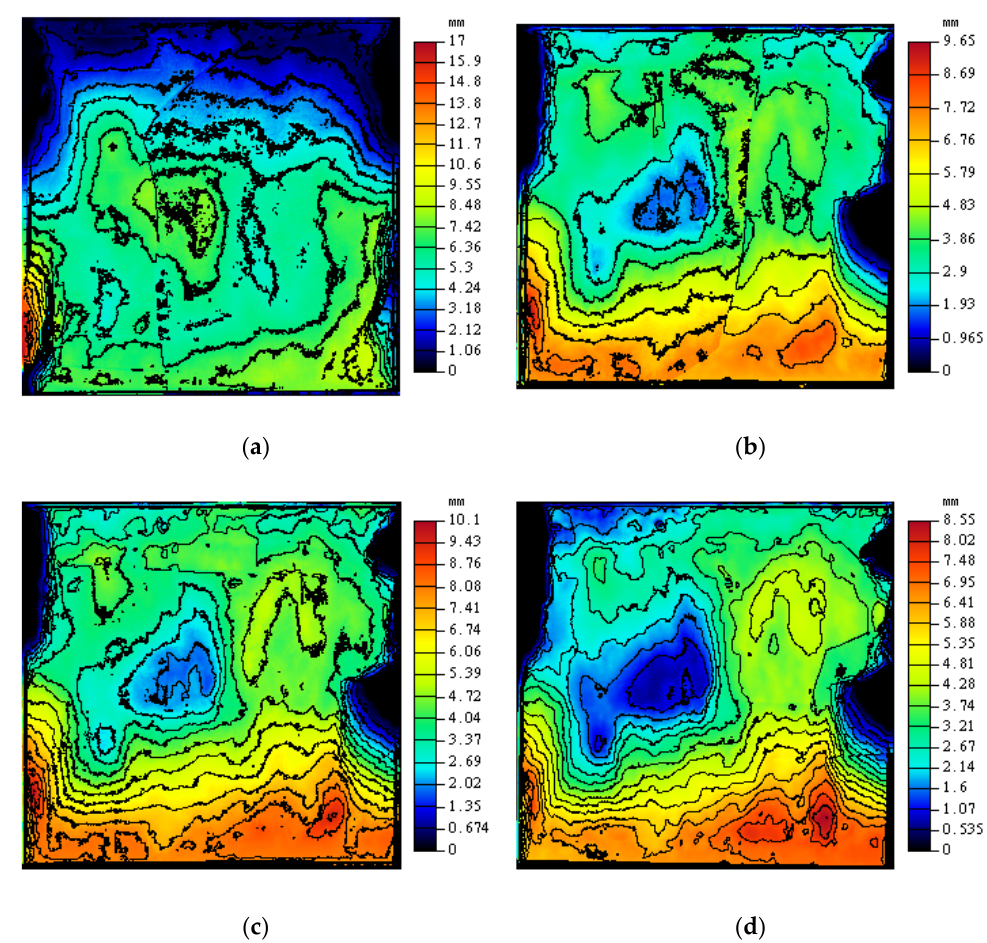
Figure 16. Contour map of CD-3 in cyclic shearing. ( a ) Before test; ( b ) First shearing; ( c ) Second shearing; ( d ) Third shearing.